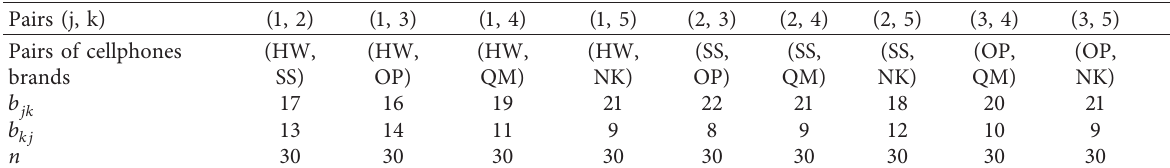
Table 1: Data regarding the cellphone brand usage preferences.